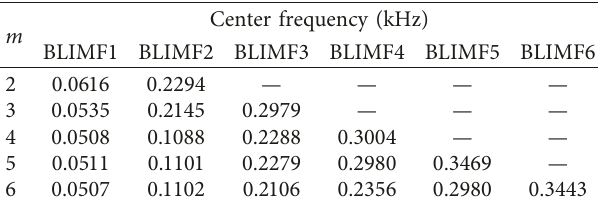
Figure 4: The time-domain waveforms for each working condition. Table 2: Center frequency corresponding to different m in